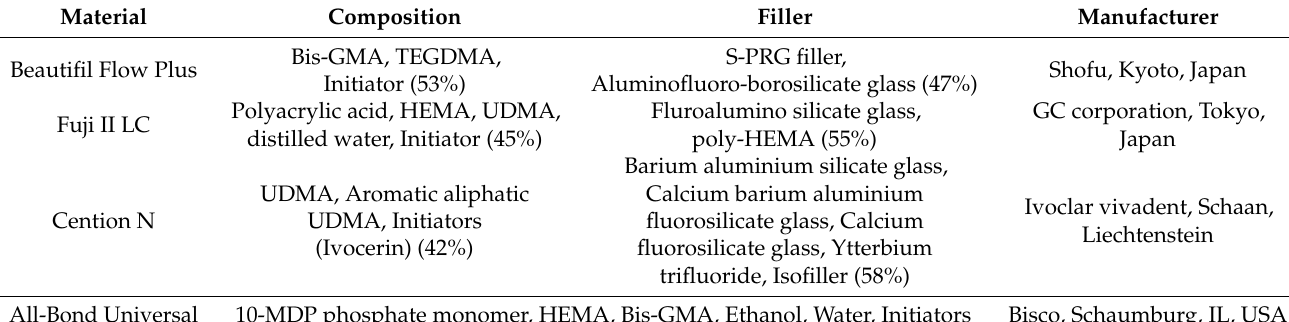
Table 1. The composition of materials used in this study. % indicates vol% in the